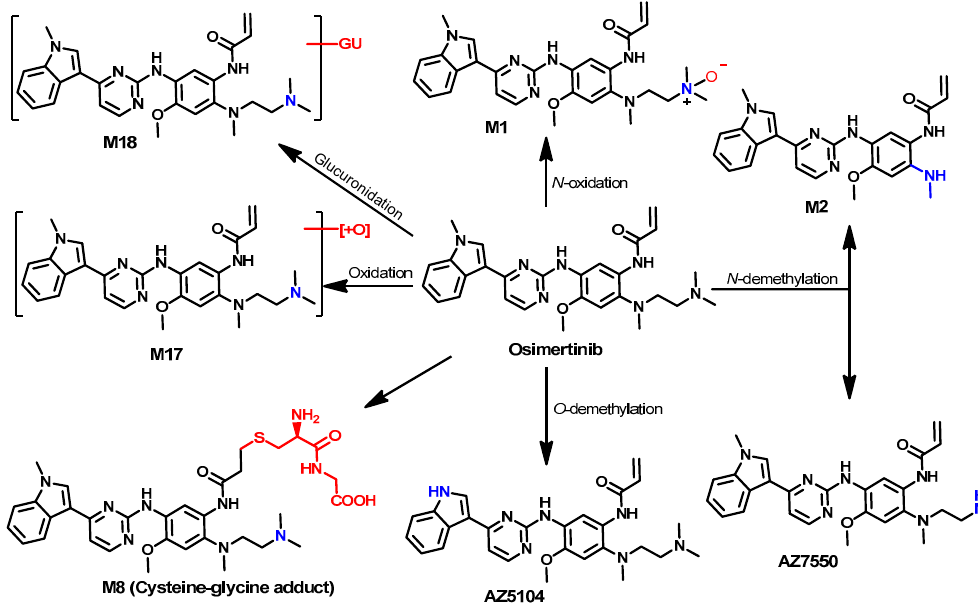
Figure 56. Proposed metabolic pathways of